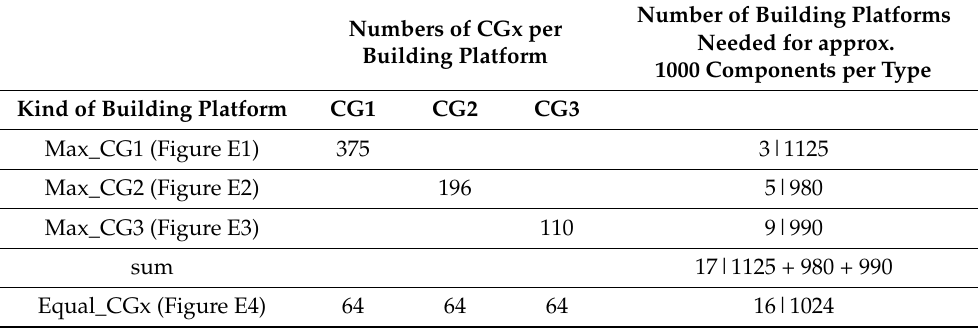
Table 2. Numbers of building platforms needed to manufacture approx. 1000 components of each cylinder geometry.